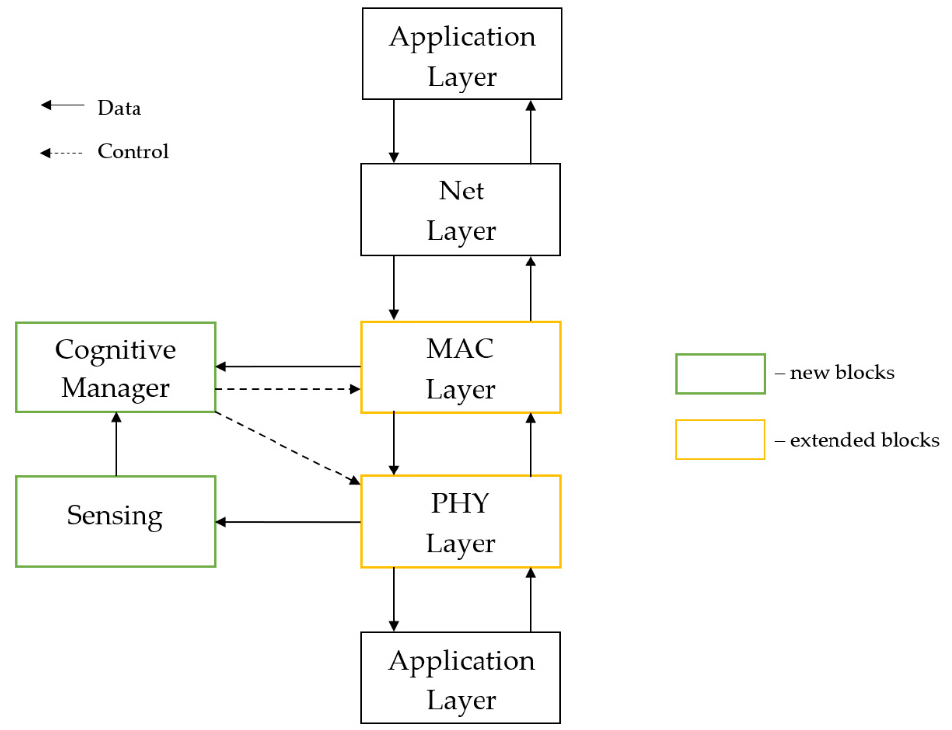
Figure 4. The architecture of the cognitive waveform.